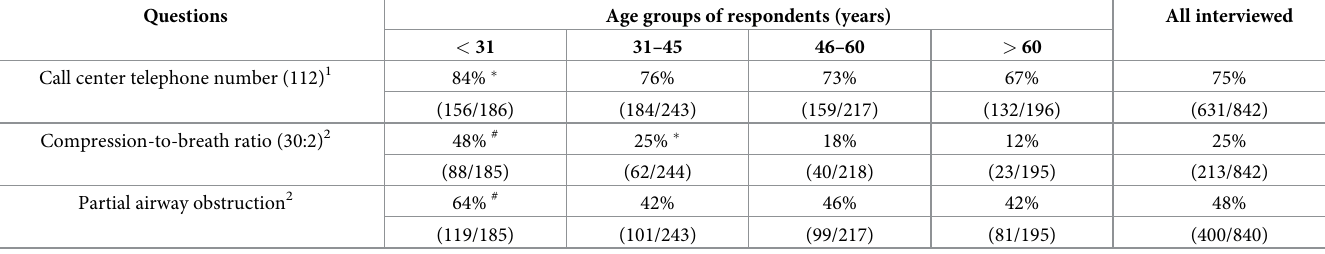
Table 2. Proportions of the correct answers to the selected questions about the first aid measures.